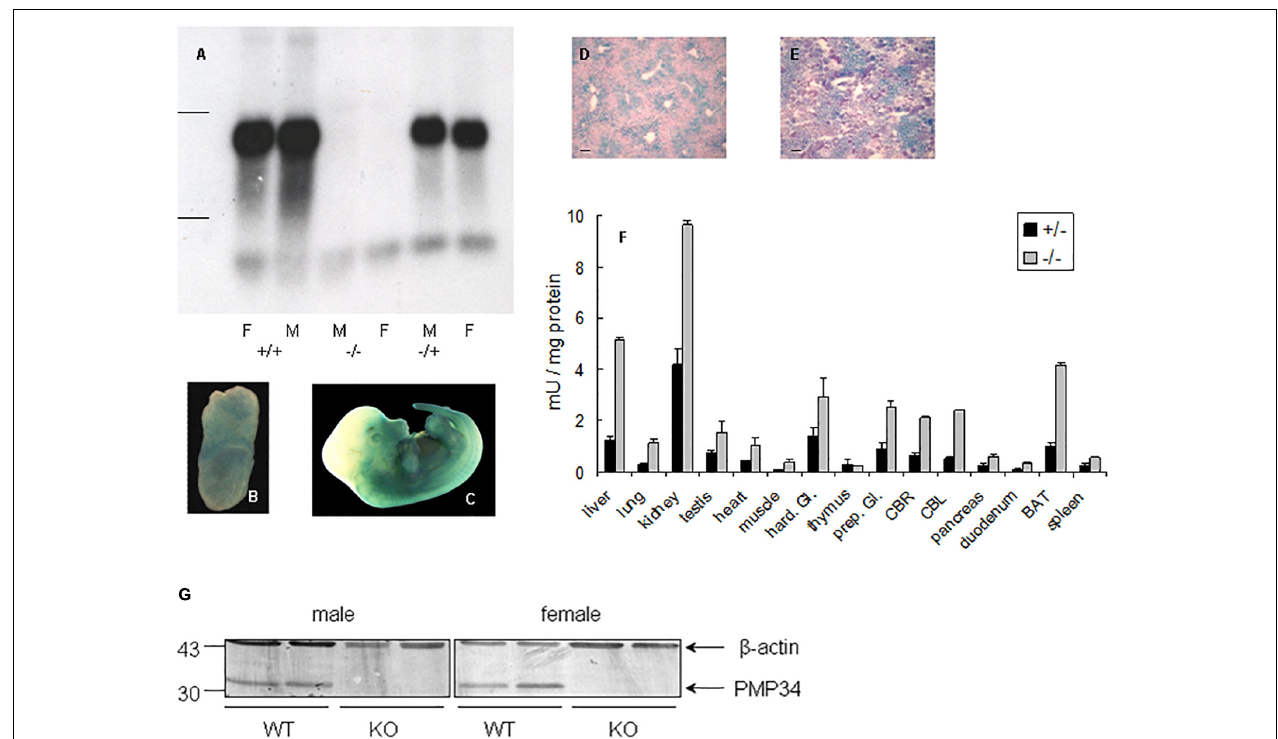
FIGURE 1 | Expression of PMP34 in murine embryonic and adult life. (A) Northern analysis of RNA isolated from liver of age matched female (F) and male (M) mice of the indicated genotypes. Migration of ribosomal markers indicated at the left. (B–E) PMP34 expression in Slc25a17 + / − embryos at different prenatal stages or in adult mice as revealed by promoter-driven β -galactosidase reporter expression: whole mount staining at E 7 . 5 (B) and E 12 . 5 (C) ; stained cryosections (10 µ m) counterstained with Nuclear Fast Red from liver (D) and kidney (E) (Scale bar 10 µ m; stainings of WT samples were negative). (F) β -galactosidase activity in tissues derived from 1 month old + / − male (black bars) or adult − / male (gray bars). Values are represented as mean ± SD of separate measurements on two mice/genotype, except for liver ( n = 5 for − / − , n = 3 for + / − ). Galactosidase activities in tissues of WT mice were less then 0.05 mU/mg protein (not shown).